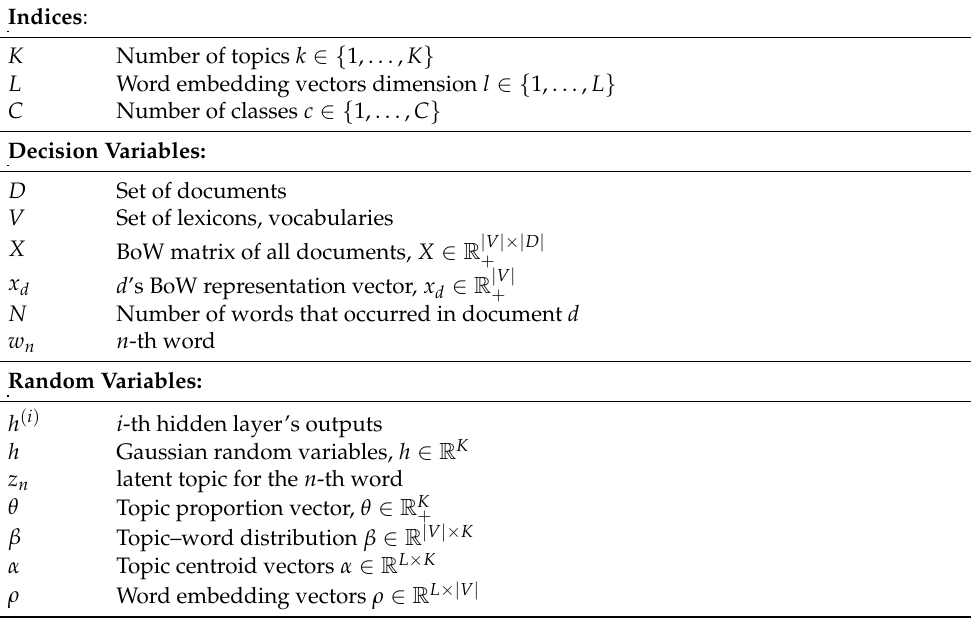
Table 1. Table of notations